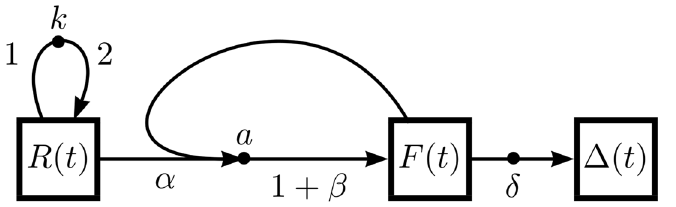
Fig 6. Lotka-Volterra flow diagram. The Lotka-Volterra model is the simplest predator-prey model. A prey species R ( “ rabbits ” ) reproduce spontaneously at rate k while a predator species F ( “ foxes ” ) consume α rabbits at rate a and convert them to β new foxes. Foxes move spontaneously at rate δ to the dead pool Δ